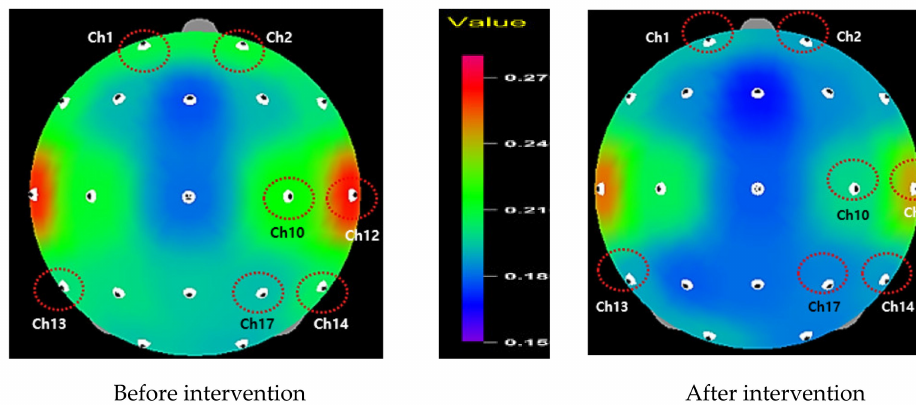
Figure 3. Relative beta wave.